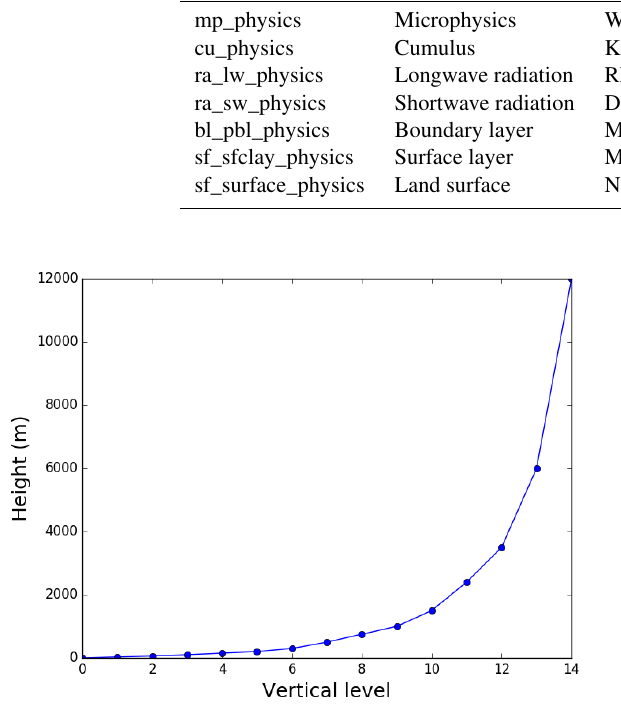
Figure 2. Vertical levels used in all regional-scale simulations per- formed with Polair3D and SinG.